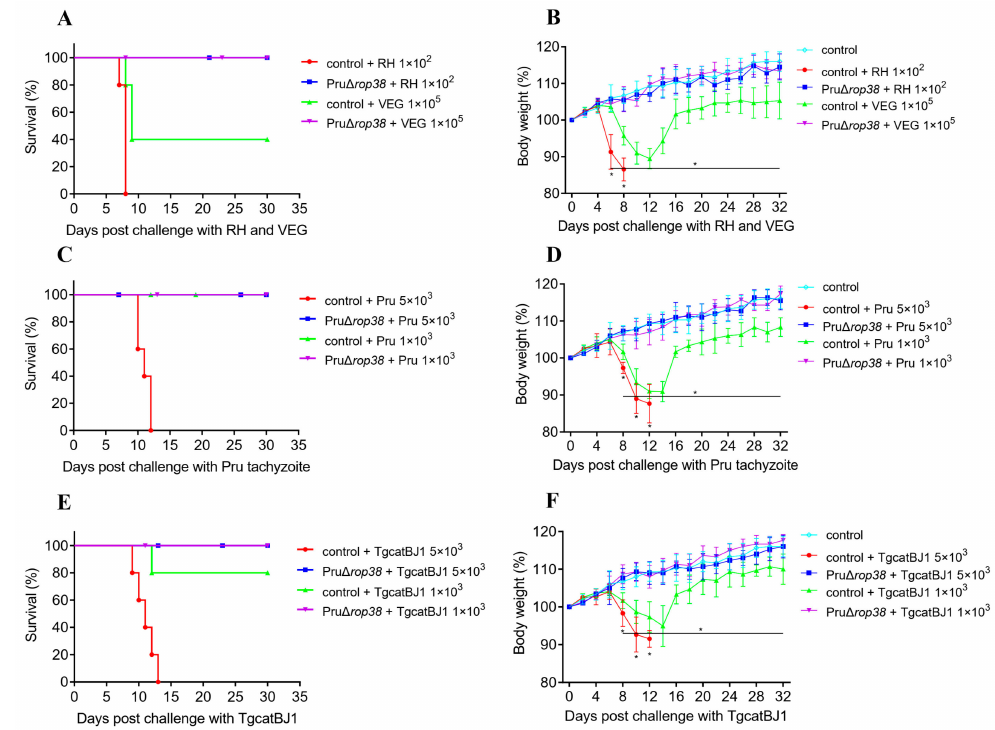
Figure 4. Protective efficacy against varied genotypes of tachyzoite challenge. Survival rate and body weight gain of vaccinated and control mice re-challenged with ( A , B ) RH (1 × 10 2 ) and VEG (1 × 10 5 ) tachyzoites, ( C , D ) Pru (1 × 10 3 and 5 × 10 3 ) tachyzoites, and ( E , F ) TgCatBj1 (1 × 10 3 and 5 × 10 3 ) tachyzoites, respectively. ( n = 5; mice were injected intraperitoneally (i.p.); daily monitoring of mice for 30 days; presented as the mean of body weight ± SD; * p < 0.05; one-way ANOVA with